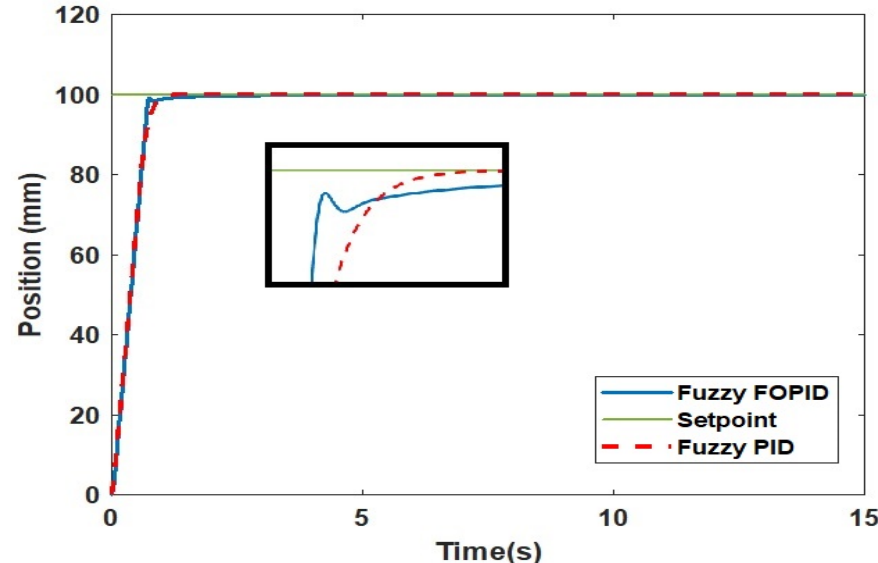
Figure 16. Fuzzy FOPID and fuzzy PID simulation performances (100 mm fixed position).